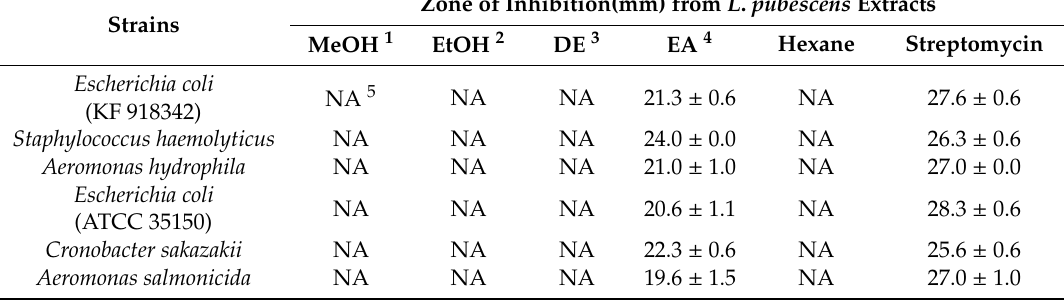
Table 2. Antibacterial activity of Lavandula pubescens using extracts with di ff erent solvents. Each value is the average of three trials ± standard